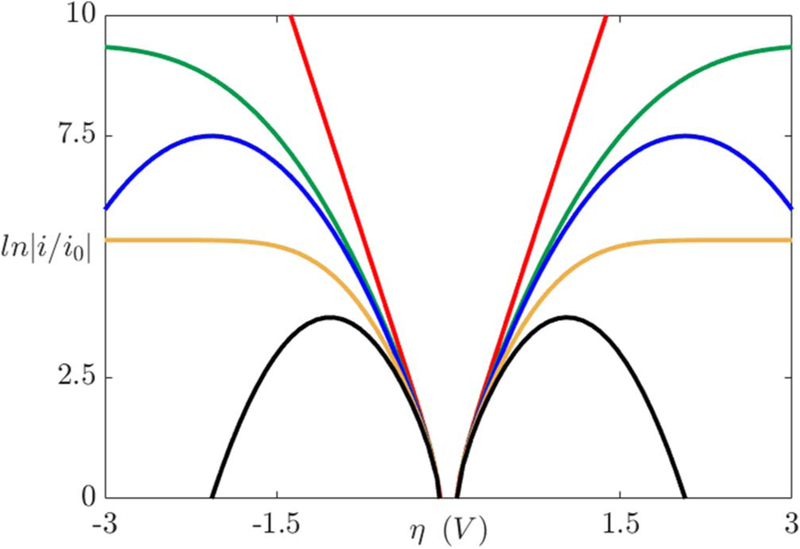
Variation of the current density as function of the overpotential: Butler-Volmer β = 0.5 (red line), Marcus-Hush-Chidsey λ = 30 (green line), Marcus λ = 30 (blue line), Marcus-Hush-Chidsey λ = 15 (yellow line), Marcus λ = 15 (black line). 69